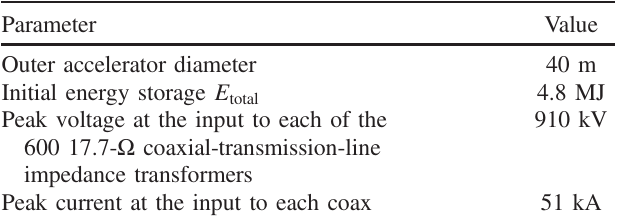
TABLE I. Summary of Neptune accelerator and load param- eters for a shot that delivers 20 MA to an 18 -m Ω load in a 380-ns linear-ramp current pulse.